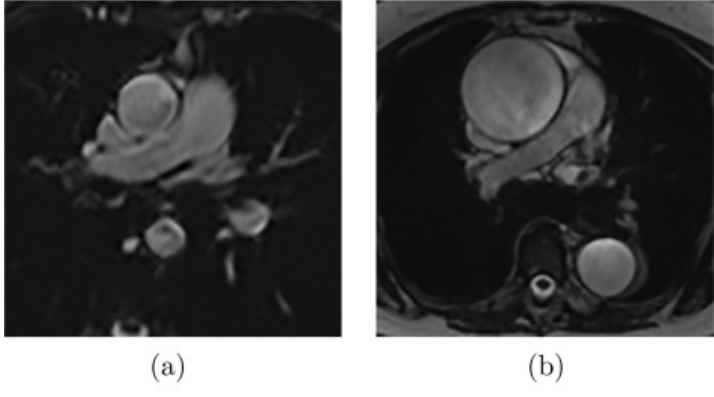
Figure 3. Examples of MR images where ( a ) the aortic wall is not well-defined due to the influence of the proximity of other structures or ( b ) the aorta is highly dilated [20].